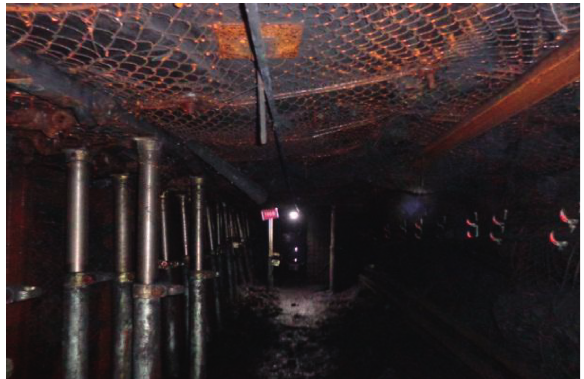
Figure 13: Effect of retaining the entry in the track crossheading of the 2103 working